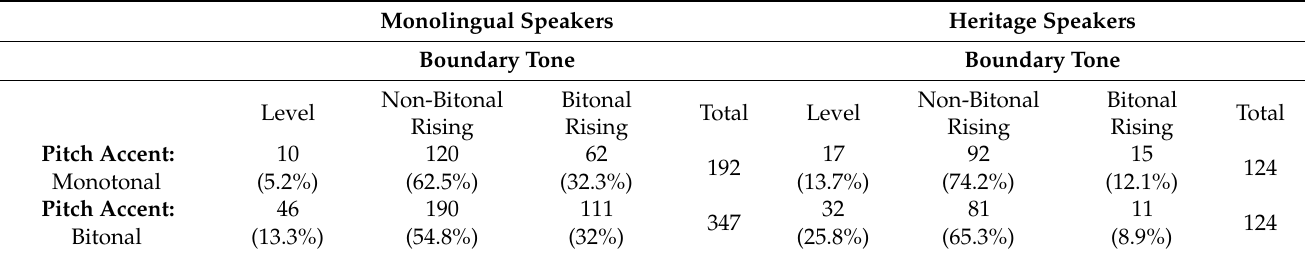
Table 4. Cross-tabulation of group, boundary tone (simplified), and pitch accent